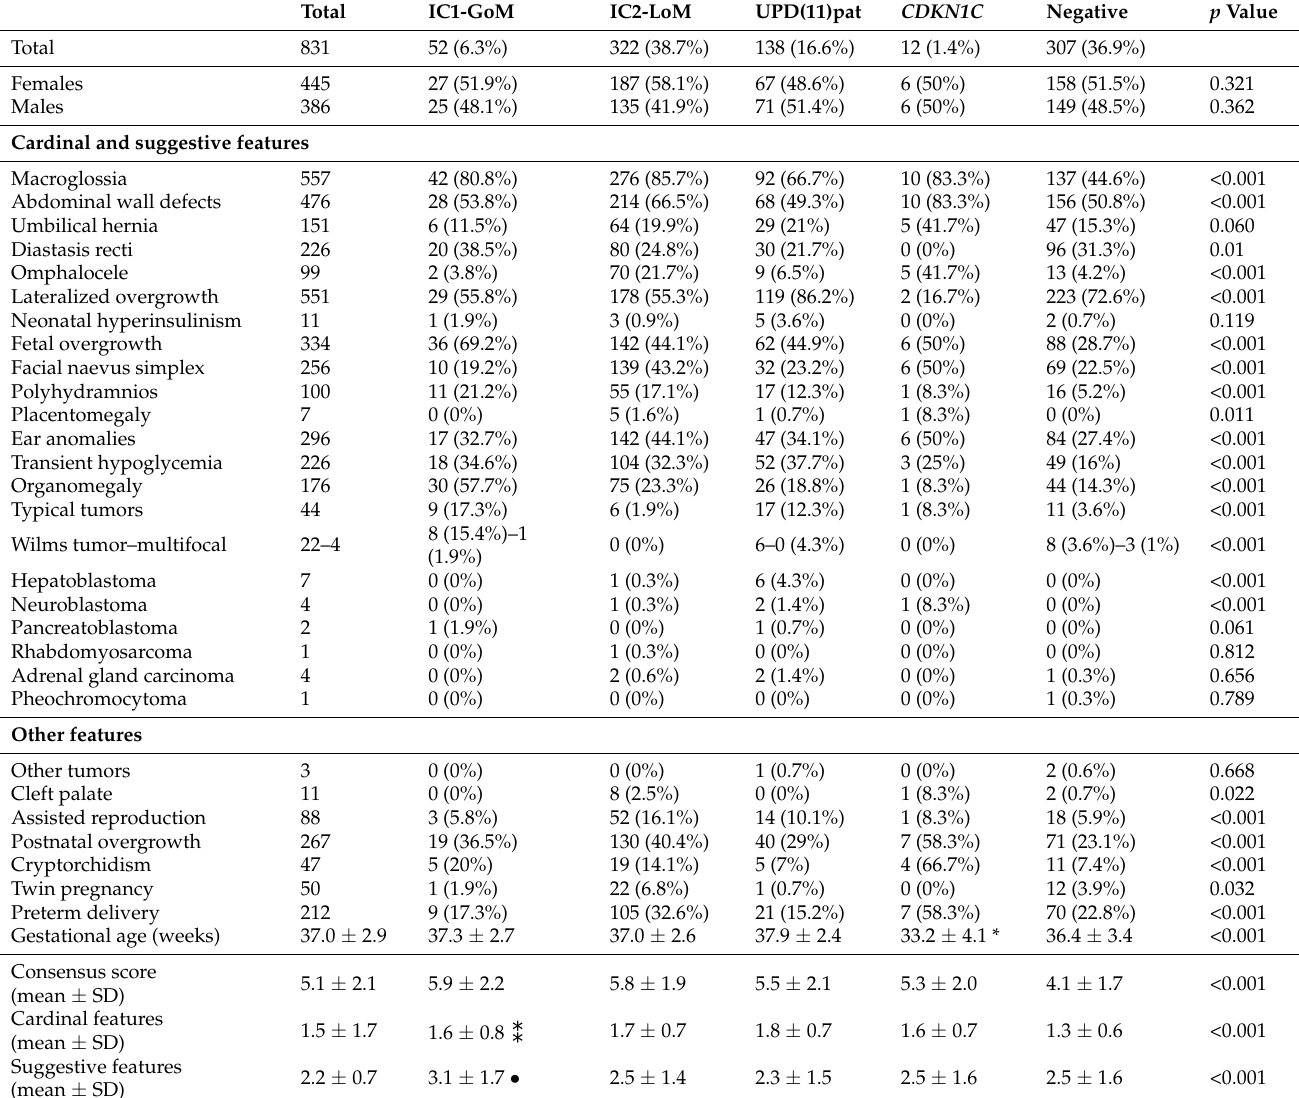
Table 2. Clinical features and diagnostic criteria of the study group divided by molecular